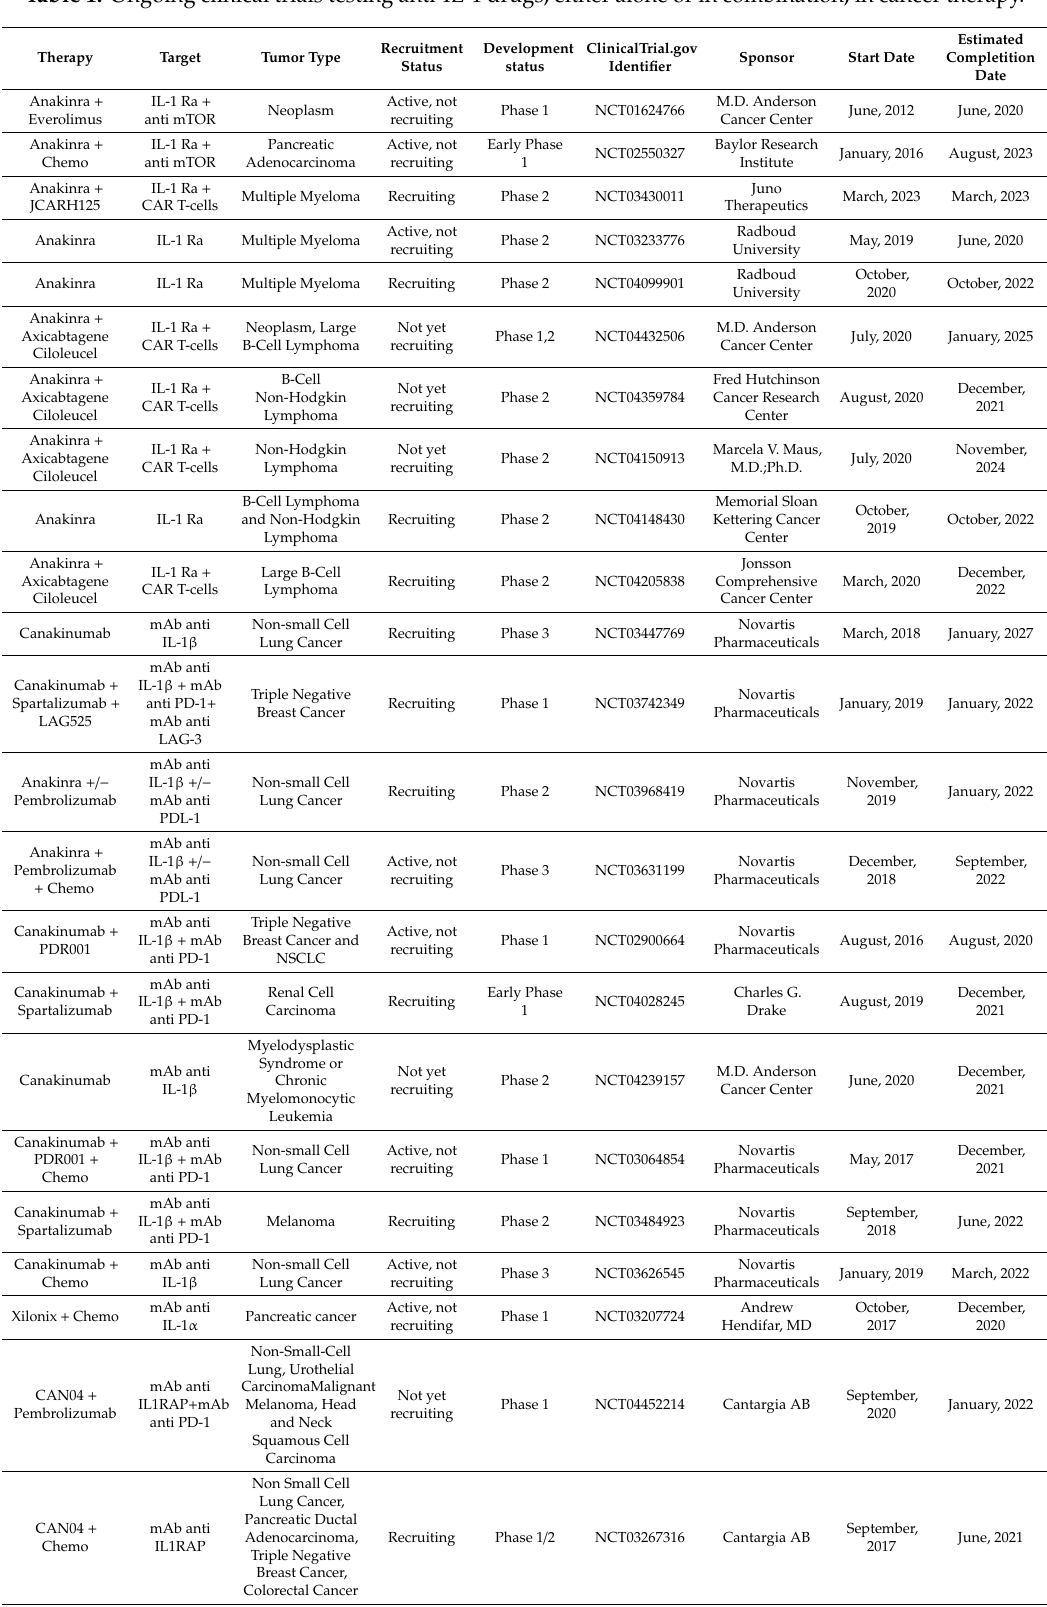
Table 1. Ongoing clinical trials testing anti-IL-1 drugs, either alone or in combination, in cancer